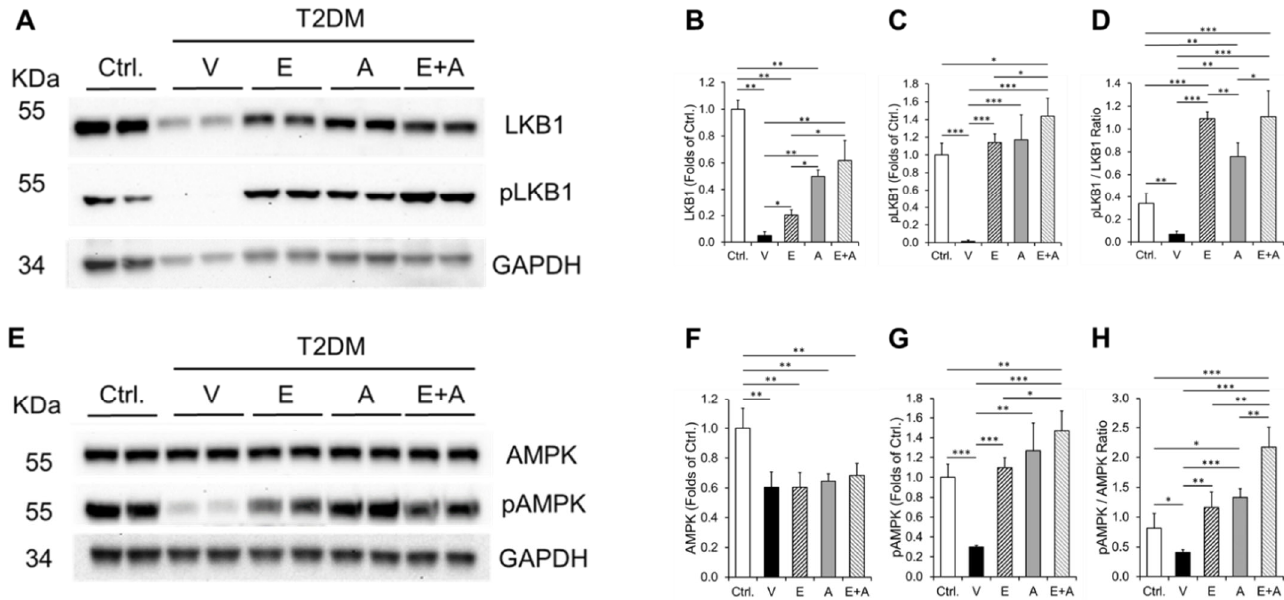
Figure 6. Levels of LKB1, phospho LKB1, phospho LKB1/LKB1, AMPK, phospho AMPK and phospho AMPK/AMPK in diabetic ALDH2*2 mutant mice exhibiting HFpEF with vehicle, EMP, Alda-1 and EMP + Alda-1 treatments. Representative Western blot images of LKB1, phospho LKB1 (pLKB1 i.e., Ser428) and loading control GAPDH ( A ) and the respective densitometric quantification data of LKB1 ( B ), pLKB1 ( C ), pLKB1/LKB1 ( D ). Representative Western blot images of AMPK, phospho AMPK (pAMPK i.e., Thr172) and loading control GAPDH ( E ) and the respective densitometric quantification data of AMPK ( F ), pAMPK ( G ) and pAMPK/AMPK ( H ) were shown. Data are pre ‐ sented as mean ± standard error of the mean (SEM). n = 4. * p < 0.05, ** p < 0.01 and *** p < 0.001 refer to the difference between individual groups as shown in Figure 5B–D to Figure 5F–G.